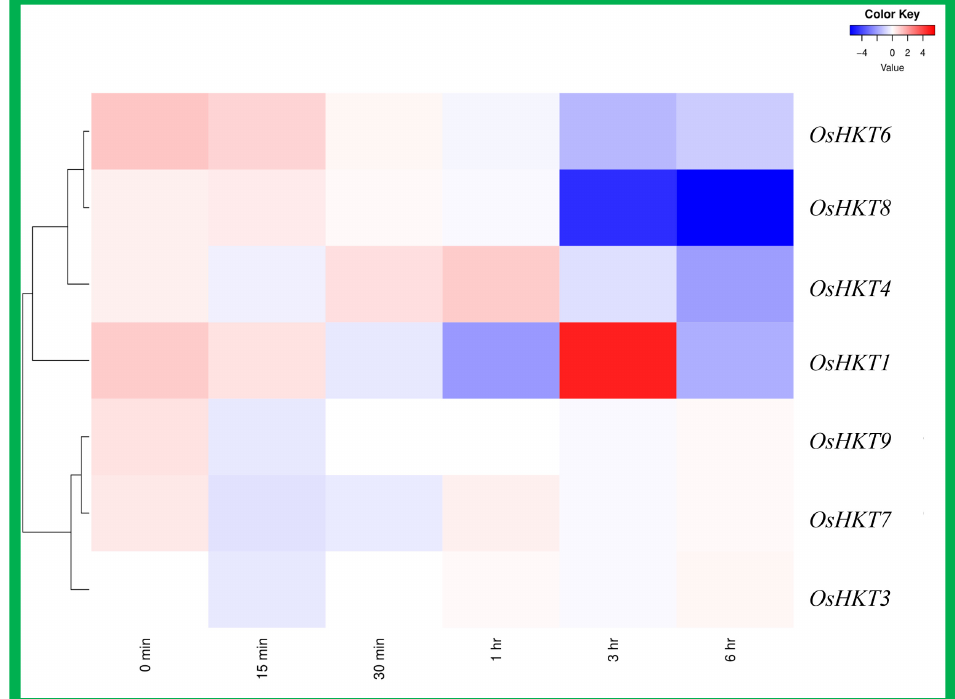
Figure 9. Expression analysis of OsHKT genes in rice roots under Jasmonic acid application. Rows represent OsHKT members, and columns show different time points. The expression level of OsHKT [log2 (FPKM + 1)] is indicated by the intensity of color: red represents high expression and blue represents low expression.